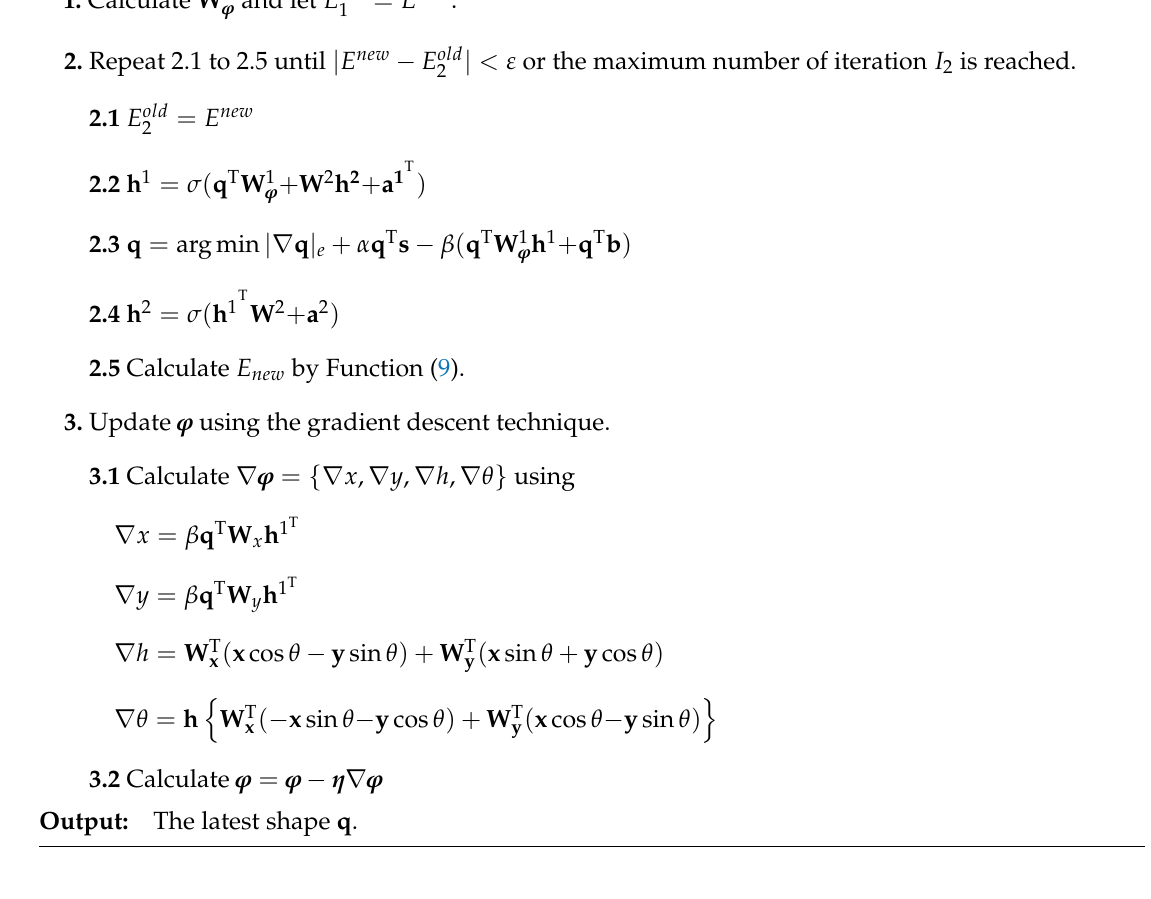
Algorithm 1 Optimization